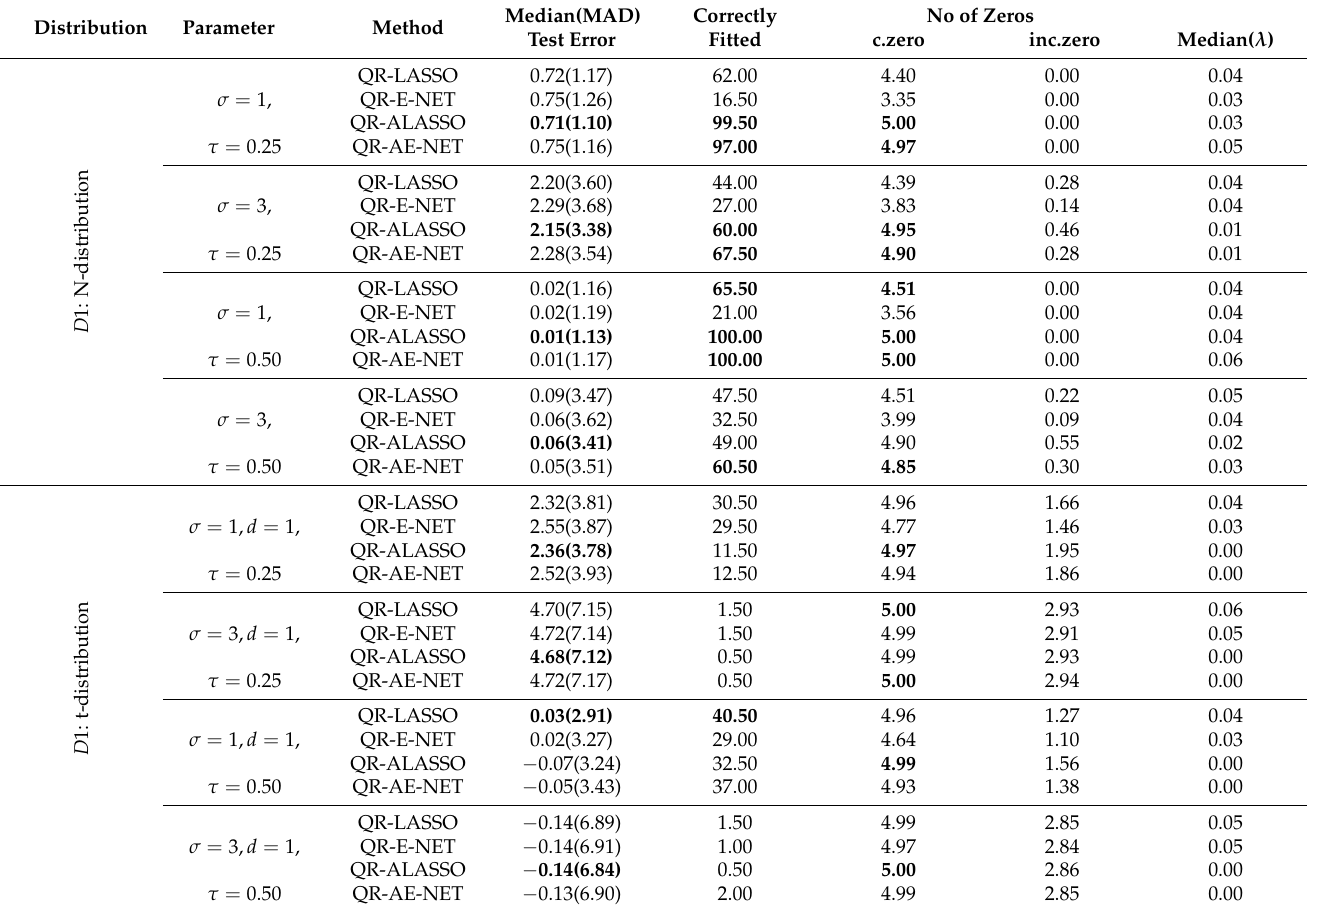
Table 1. Penalized unweighted quantile regression at D 1 for n = 50 ( τ = 0.25 and τ = 0.50) under the normal and heavy tailed t-distributions; bold text indicate superior